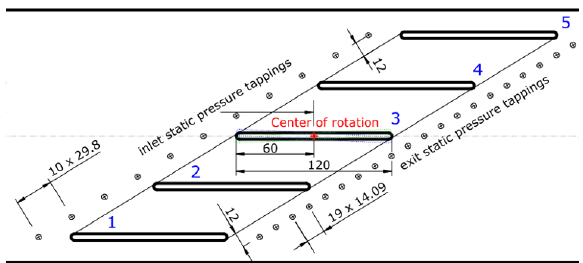
Figure 2. Geometry of the blade cascade.